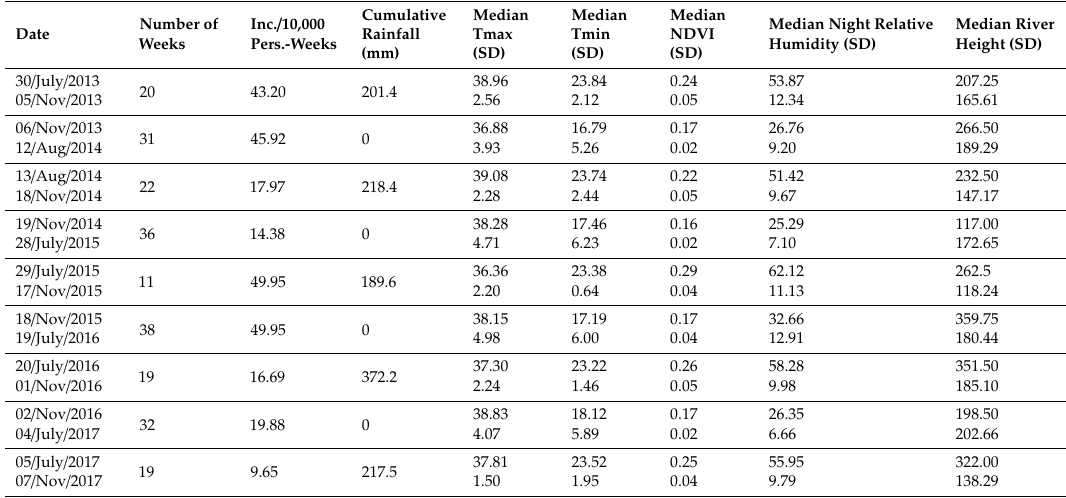
Figure 1. Evolution of weekly malaria incidence according to meteorological factors in Dire health district, 2013–2017. ( a ) The incidence per 10,000 person-weeks is represented by the red line, the dry season by the light grey bar, and the rainy season by the dark grey bar. ( b ) Weekly rainfall accumulation (mm) is represented by the dark blue histogram, median maximum temperature (°C) by the solid black line, and median minimum temperature (°C) by the dashed black line. ( c ) normalized difference vegetation index (NDVI) is represented by the light green line (On the secondary axis) and river height (cm) by the light blue line.